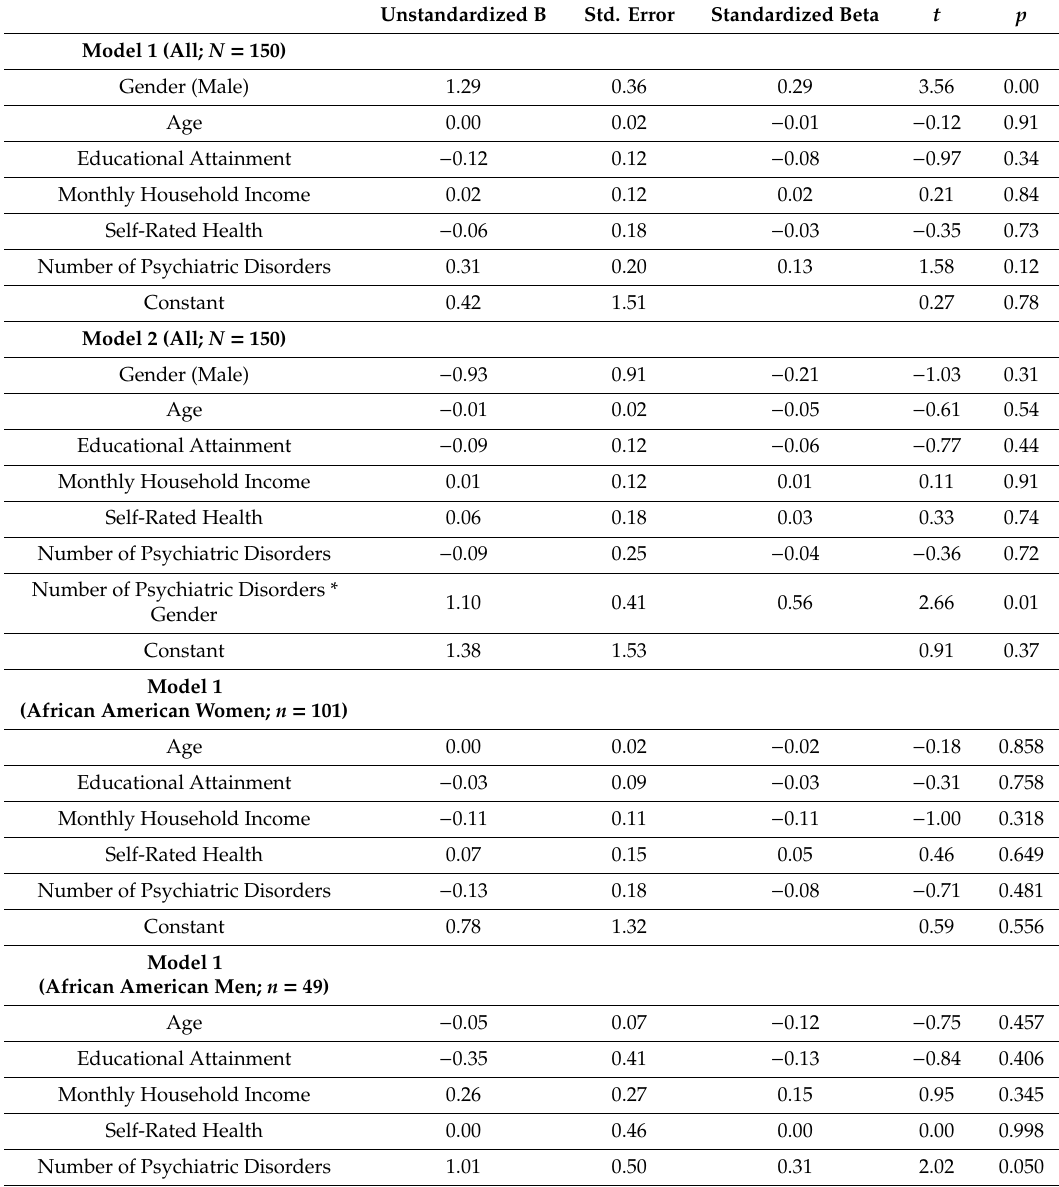
Table 3. Summary of linear regressions in the pooled